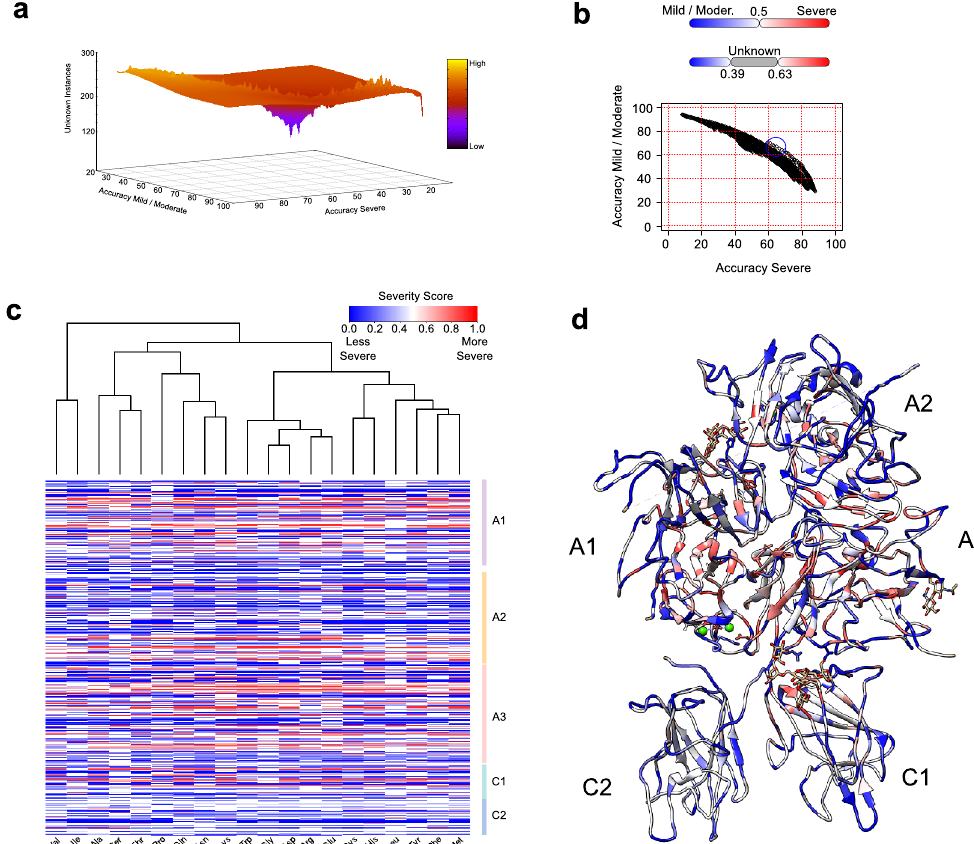
Fig. 3 Hema-Class re fi nement and predictions. a The accuracy of the severe and the mild/moderate classes varies depending on the Severity Score cutoffs. Changing the Severity Score cutoffs effectively creates a “ gray zone ” where fewer instances are classi fi ed, but with higher accuracy. Depicted is the landscape created by varying the cutoff values. b Each dot is a combination of a minimum and maximum Severity Score cutoffs, and the blue circle depicts the values that enabled Hema-Class to achieve the best classi fi cation of FVIII point-mutations not seen during the training phase (~60% for both severe and mild/moderate classes). c Predicted Severity Score of all possible mutations of the FVIII amino acids in the FVIII structure (available in Supplementary Table 2). d FVIII structure colored by the Severity Score of each amino acid. Red indicates a higher probability of loss of